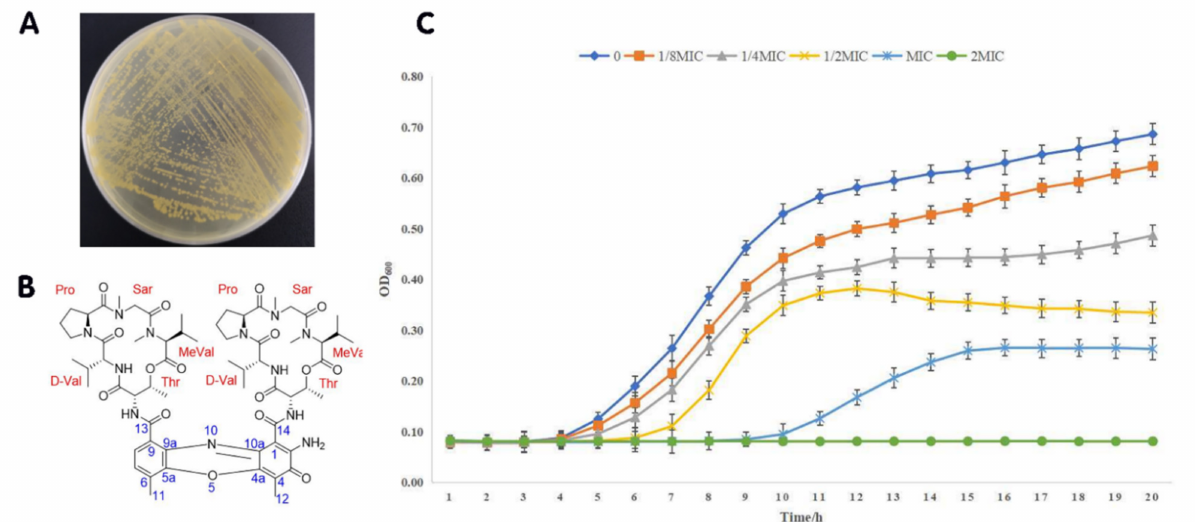
Figure 1. Structural characteristics and anti- S. aureus activity of actinomycin D. ( A ) S. parvulus cultured on LBA. ( B ) Structural characteristics of actinomycin D. ( C ) Anti- S. aureus activity of actinomycin D. OD 600 represents the optical density under the scanning wavelength of 600